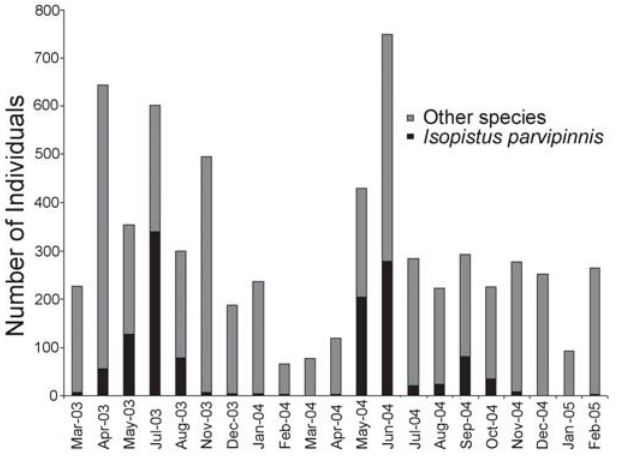
Fig. 3. Total number of Isopisthus parvipinnis individuals captured per sampling month along the coast of Ilhéus, Ba- hia,